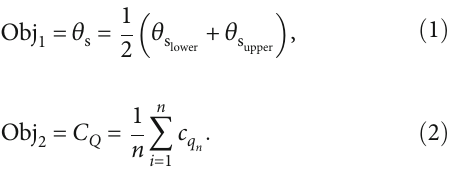
Figure 3: Cylinder with 18 segments alternating between c at the cylinder